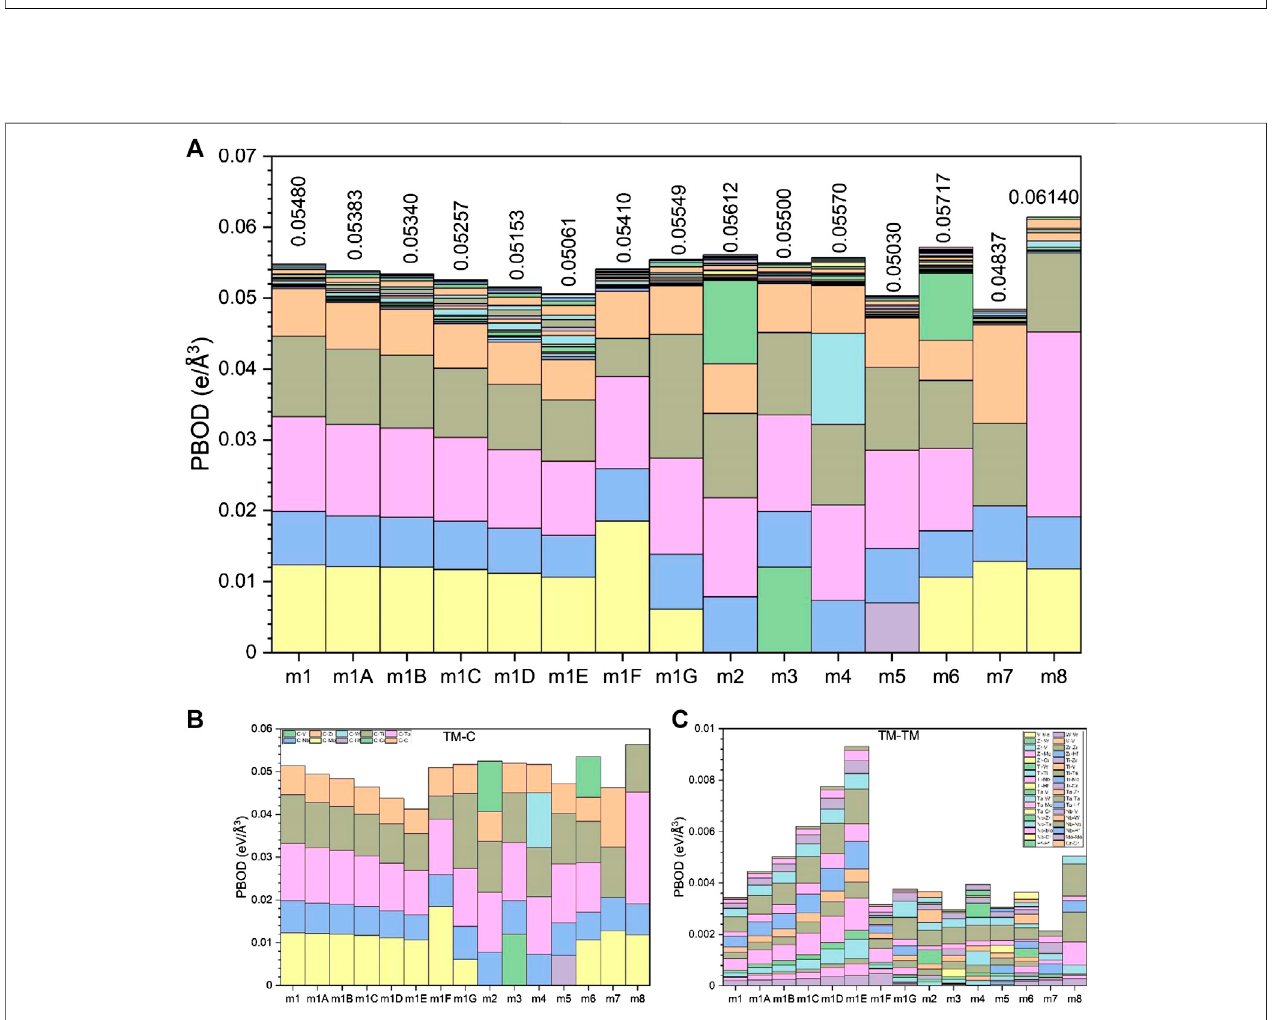
FIGURE 5 | (A) TBOD and PBOD in histogram form for all 15 models. (B) TBOD and PBOD between TMs and C in the 15 models. (C) TBOD and PBOD among TMs for the 15 models.